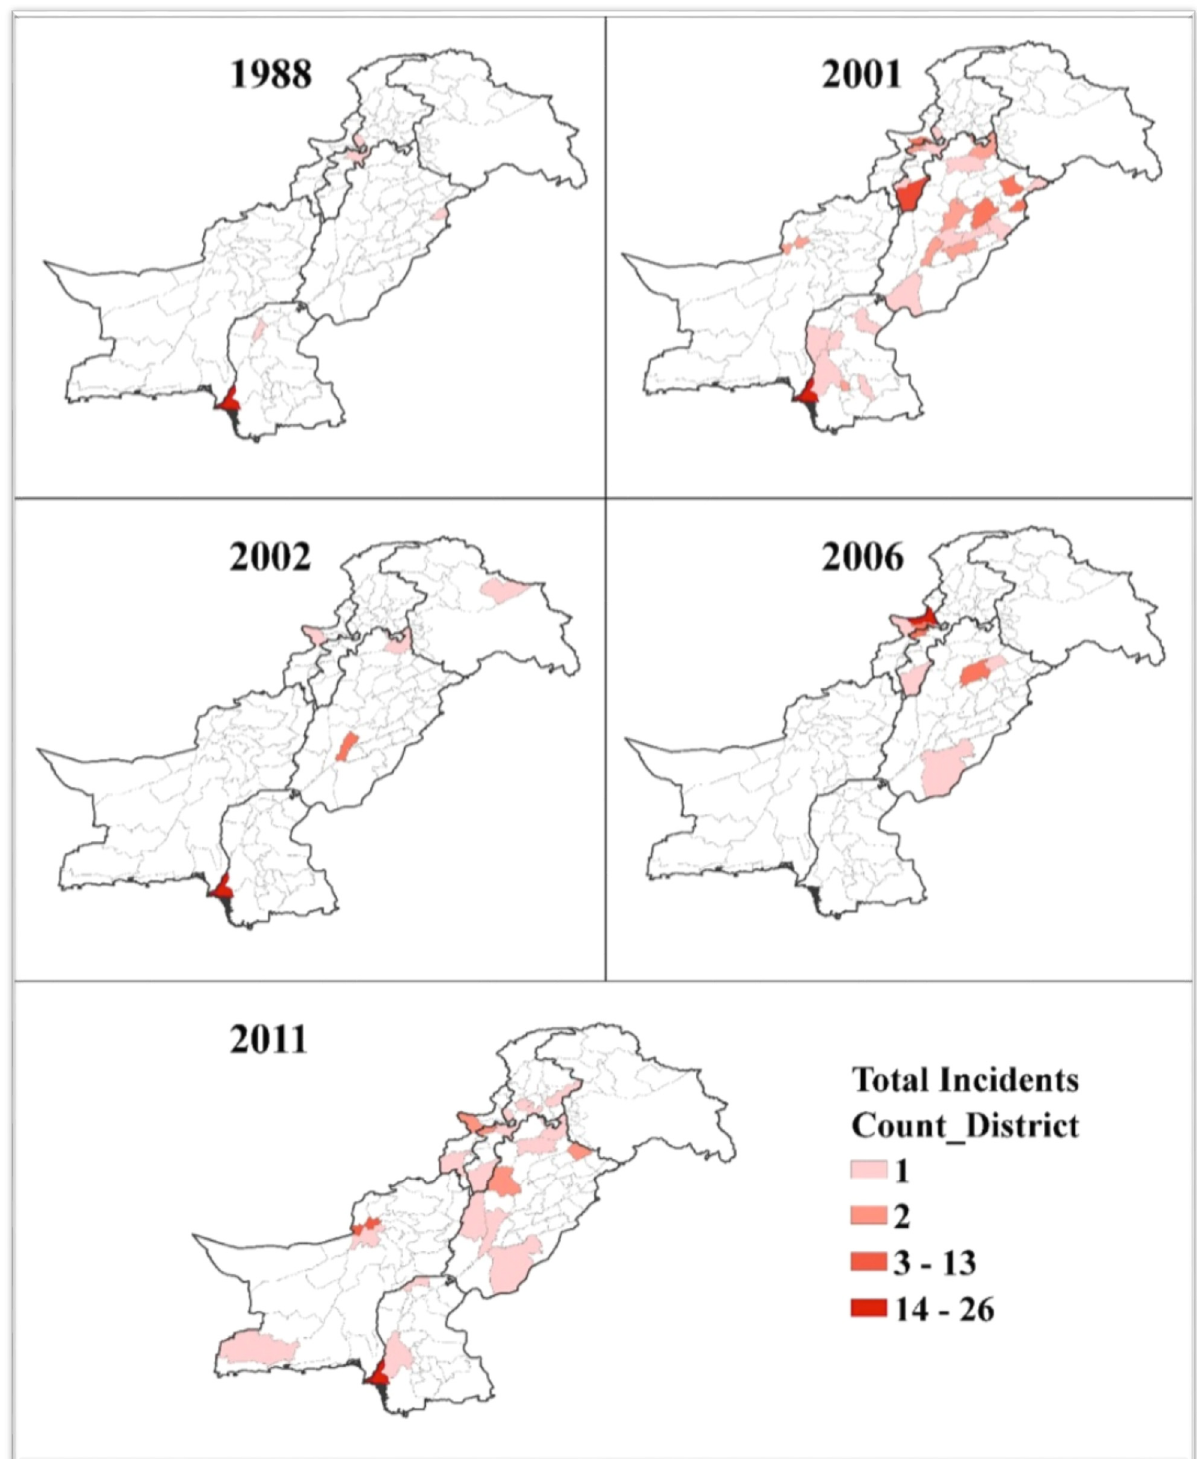
Figure 2. Sectarian Violence in Pakistan-Selected Years. Source: In-house manipulations of BFRS dataset [29,61] by Jesse